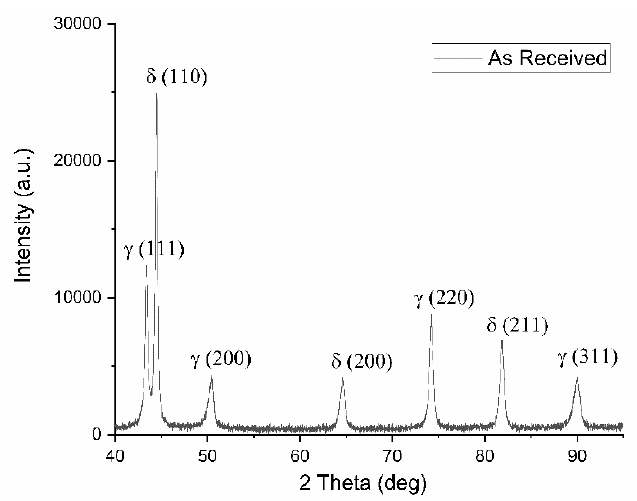
Figure 3. X-ray diffraction pattern of the as received material along rolling direction.